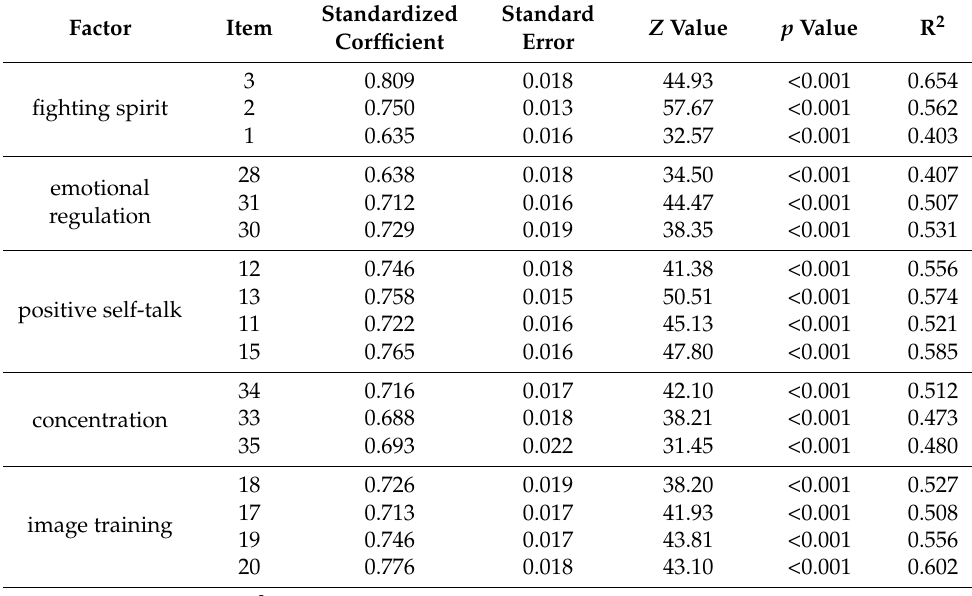
Table 13. Results of ML